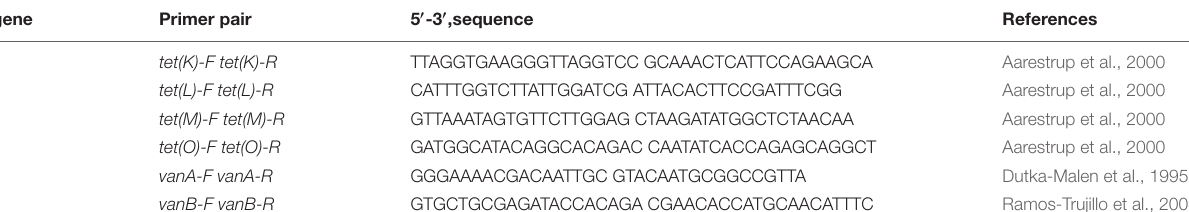
TABLE 1 | PCR primers used in this study. Target